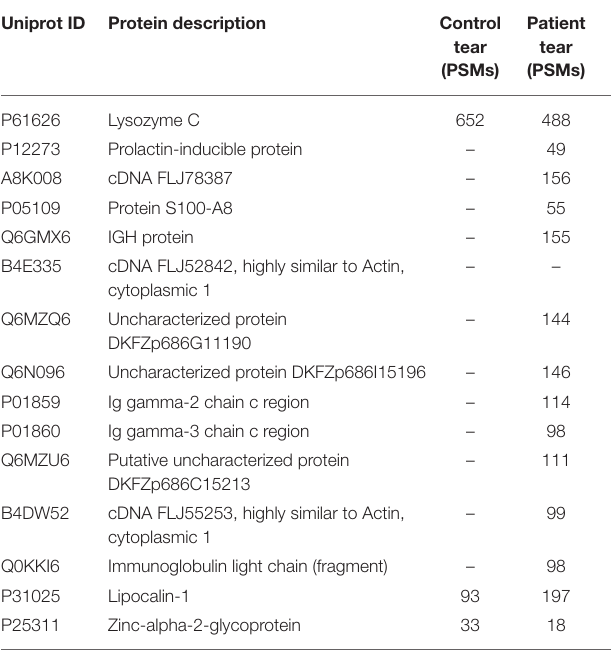
(B) COMPARISON OF THE SPORE BOUND PROTEINS OF CONTROL AND PATIENT TEAR FILM Uniprot ID Protein